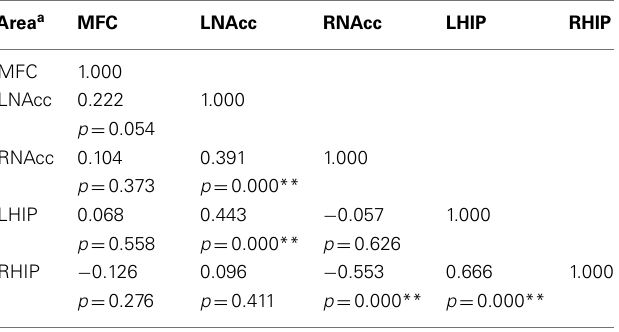
Table 6 | Functional connectivity between regions of interest during all three task conditions at week